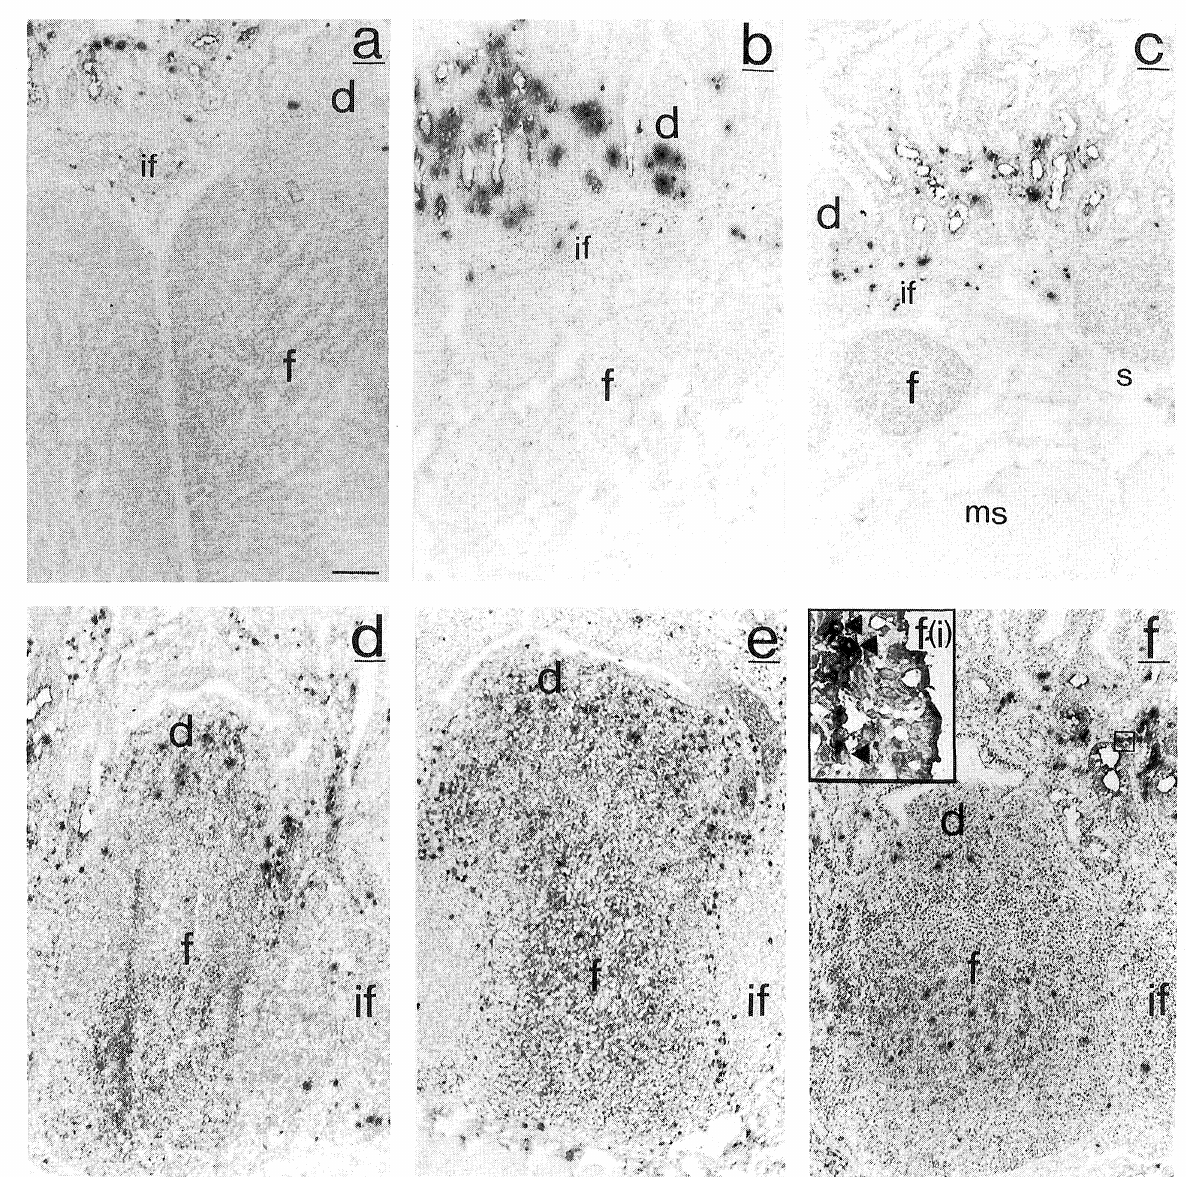
FIGURE 6. Immunoperoxidase staining for IgA revealed a similar distribution of IgA PCs in the PPs in age-matched, untreated lambs (control) and lambs treated for 7 days with 2 mg dexamethasone/kg BW (postdex), Ileal PP: a (control); b (D.21--postdex); (D.74--postdex). IgA PCs in the ileal PP were located primarily in the lamina propria, adjacent to the villus crypt, and rare PCs are seen in the interfollicular (if) and dome (d) region but never in follicles (f). Jejunal PPs: d (control); e (D.21--postdex); f (D.74--postdex). IgA PCs in the jejunal PP were numerous in the lamina propria, adjacent to the villus crypt, and numerous in the dome region (d), in the follicle (f), and the interfollicular region (if). f(i) inset: Higher magnification of area outlined in f shows intense cytoplasmic staining of PCs in the lamina propria and surface staining of the mucosal epithelium. Magnification: a-f (bar [in a] 150